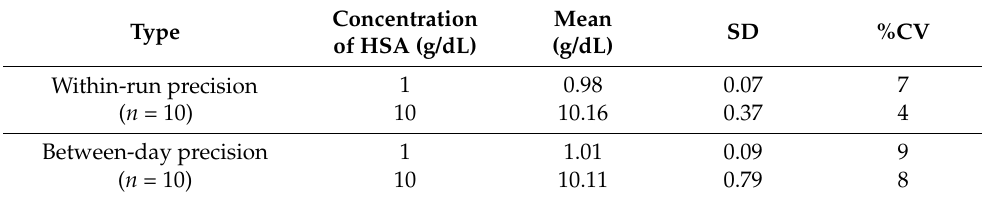
Table 4. Precision of HSA-MIP microplate assay.